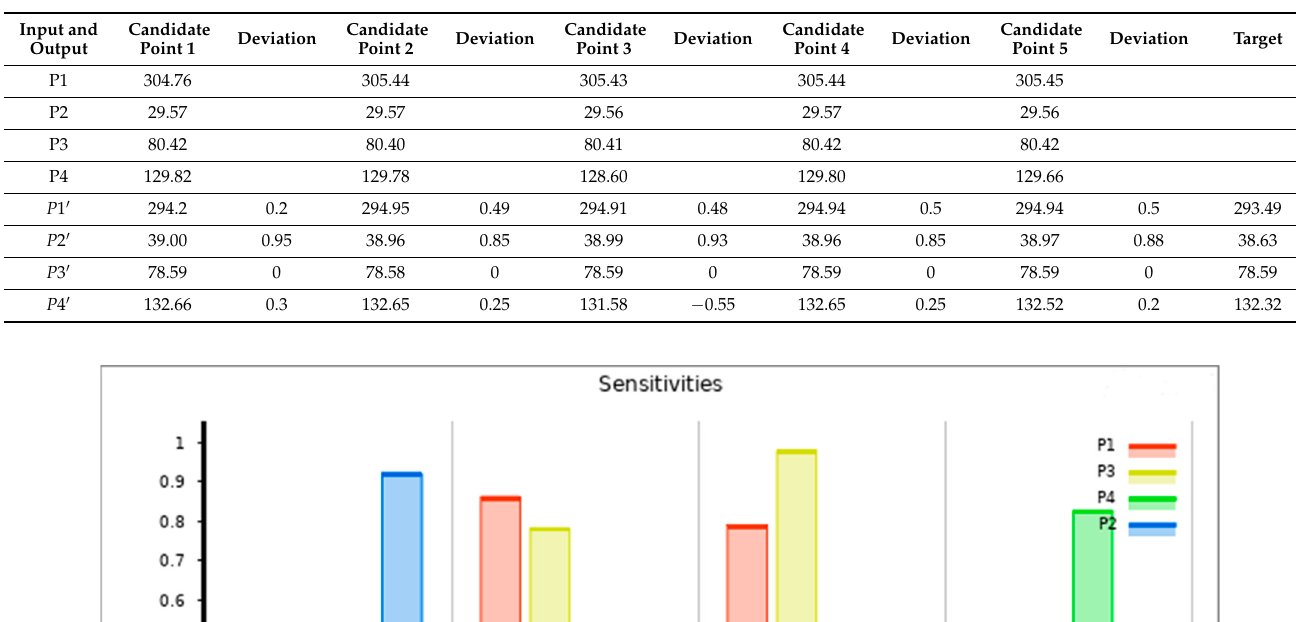
Table 2. Candidate points (all numbers are in mm).